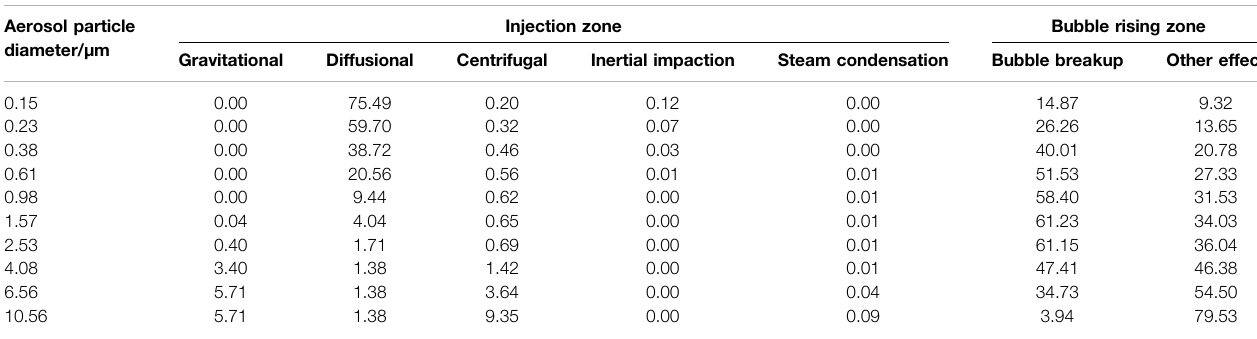
TABLE 6 | The contribution of different mechanisms to pool scrubbing